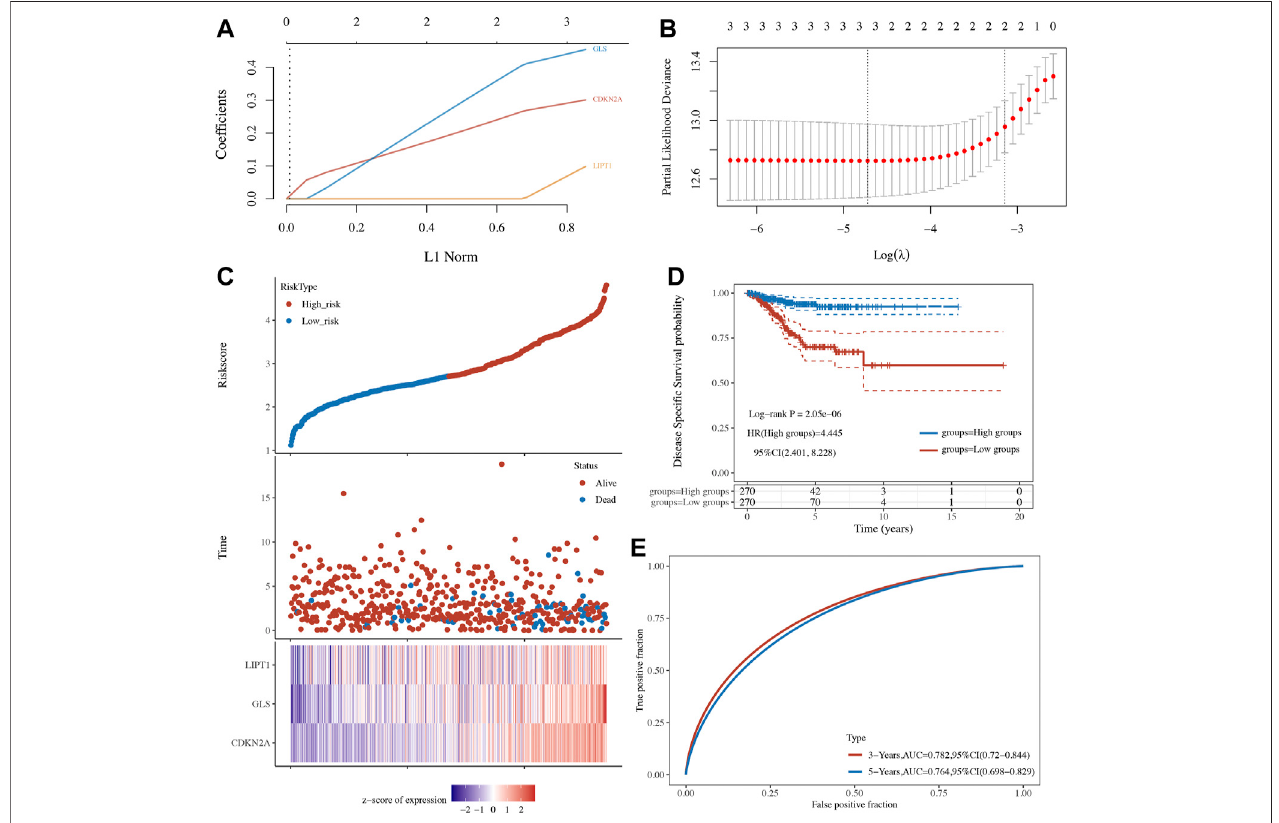
FIGURE 5 | A cuproptosis-related prognostic signature in uterine corpus endometrial carcinoma (UCEC). (A,B) Coef fi cient and partial likelihood deviance of prognosticsignature. (C) Theriskscoredistribution,patientsurvivalstatus,andcuproptosis-relatedgeneexpressionpro fi leofprognosticsignature. (D,E) Survivalcurve of UCEC patients with high/low-risk score and ROC curve of prognostic